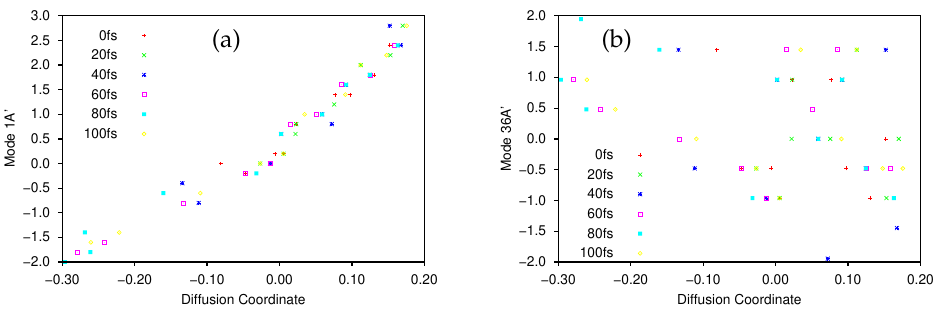
Figure 1. Sampled normal mode coordinates of salicylaldimine plotted as functions of the diffusion coordinate: ( a ) Mode 1A’; ( b ) Mode 36A’. In both cases data points are labelled according to the sample time; gridpoints were sampled every 20fs during the